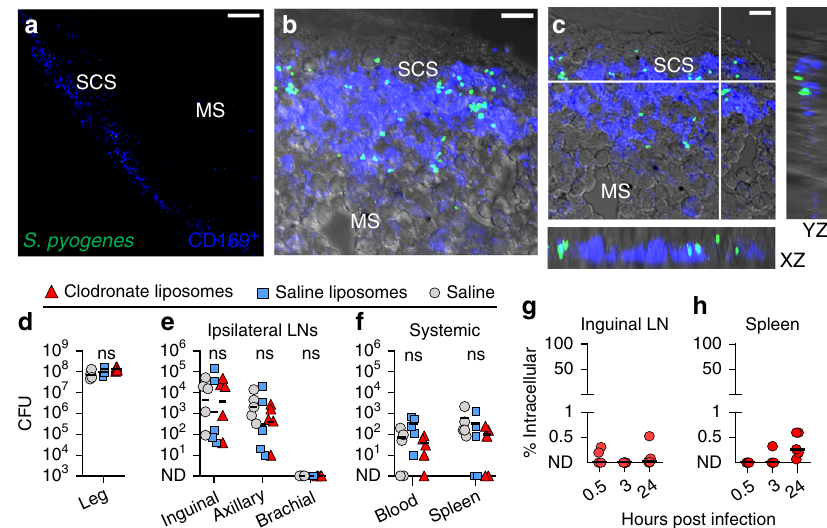
Fig. 6 S. pyogenes is extracellular within lymph nodes and evades killing by CD169 + macrophages. a – c Immuno fl uorescence staining of cryosections from the draining inguinal lymph nodes of FVB/n mice 3 h after intramuscular injection into the hindlimb with 10 8 CFU of hypervirulent S. pyogenes H1565 (green); CD169 (blue) and bright fi eld shown in grey; Overview of the subcapsular sinus (SCS) and medullary sinuses (MS) ( a ); Maximum intensity projection ( b ) and orthogonal views of a 15 µ m confocal z-stack ( c ). Scale bars: 50 µ m ( a ); 10 µ m ( b , c ). Imaging data are representative of fi ve independent experiments. See also Supplementary Movie 8. d – f Recovery of S. pyogenes H1565 from the hindlimb infection site ( d ), draining lymph nodes ( e ), and systemic organs ( f ) of FVB/n mice injected subcutaneously in the tail and leg with either clodronate liposomes (red triangles), saline liposomes (blue squares), or a saline sham (grey circles) 96 h prior to a 3-h intramuscular infection with 10 8 CFU. Symbols represent individual mice, n = 5 per group, lines indicate geometric means. ns, p > 0.5: one-way ANOVA followed by Tukey ’ s multiple comparisons post-tests were performed on log 10 -transformed data. g , h Percentage of intracellular S. pyogenes 0.5, 3, or 24 h after intramuscular infection with 10 8 CFU of S. pyogenes H1565; gentamicin protection assays on ipsilateral inguinal nodes ( g ) or spleens ( h ) of infected FVB/n mice at each time point. Each red circle represents an individual mouse, n = 5 per group, black lines indicate geometric means. See also Supplementary Fig. 6. CFU are per ml of blood, per leg, or per